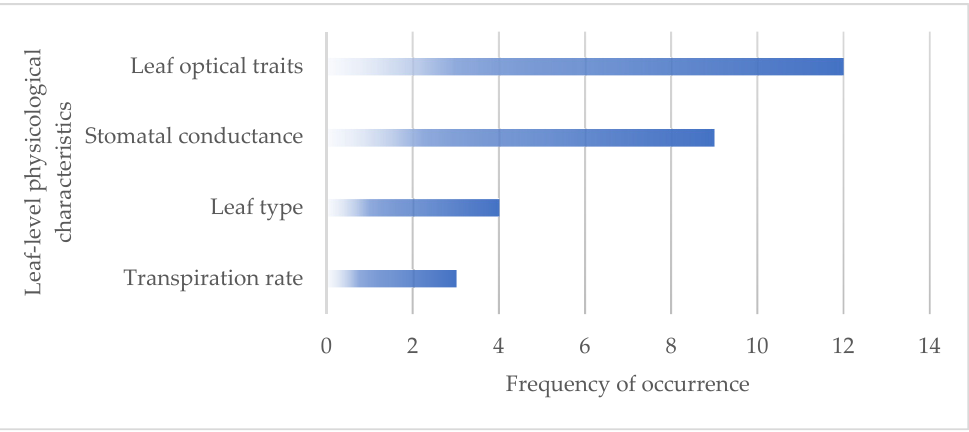
Figure 4. Frequency of occurrence of crown-level physiological characteristics of trees in the 48 papers analyzed.